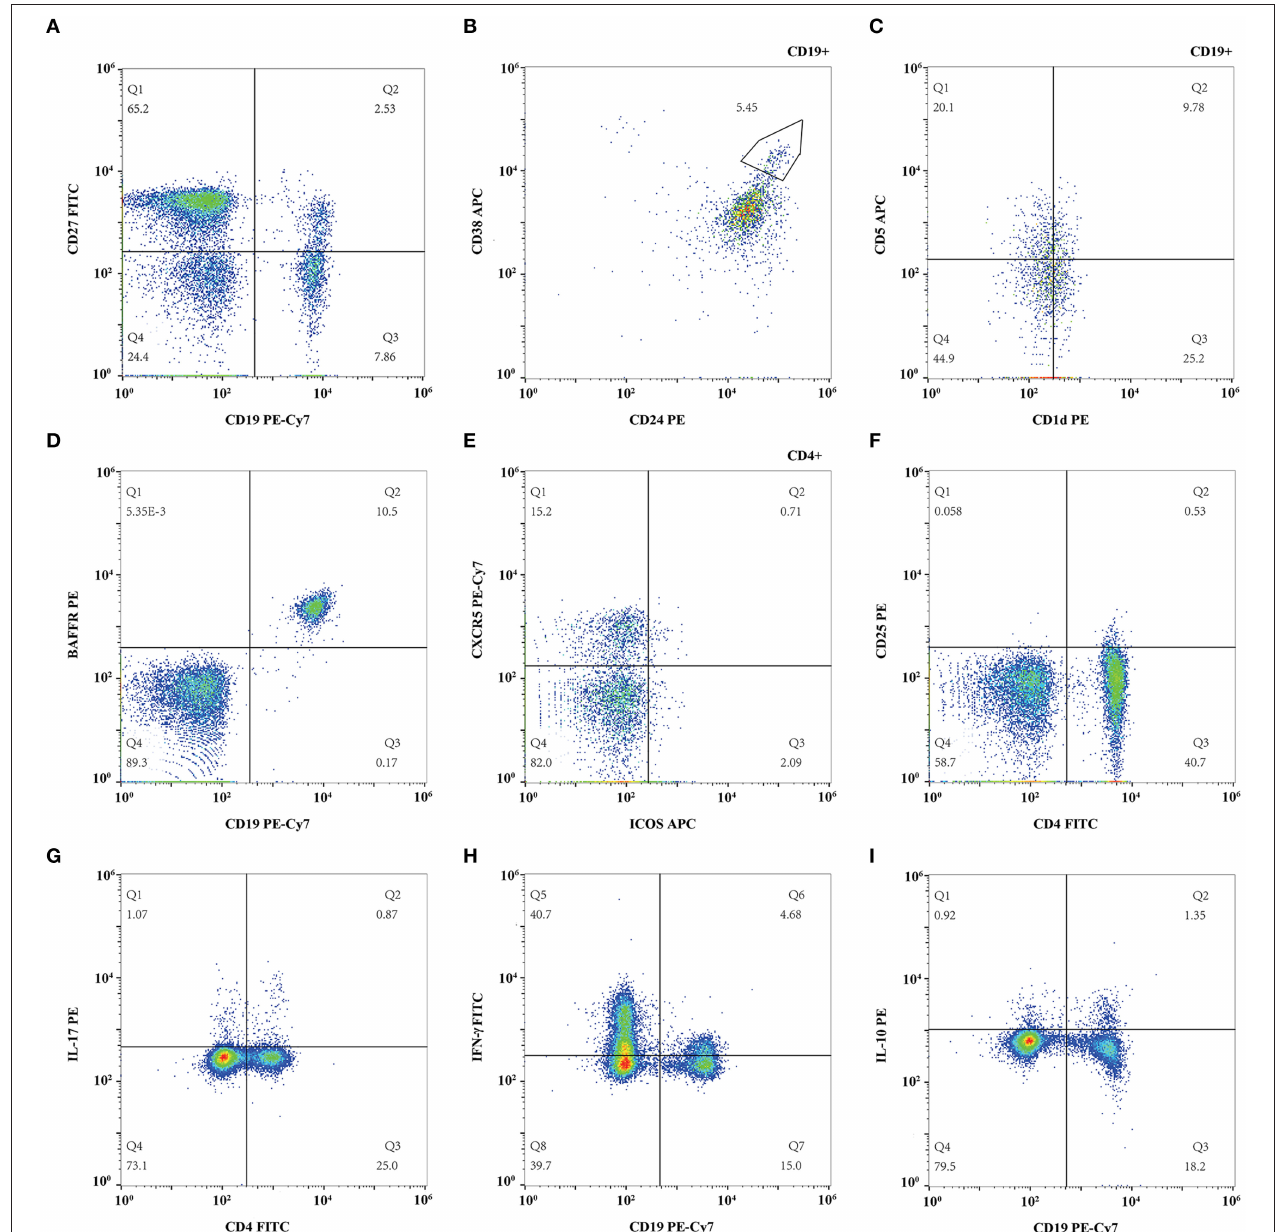
FIGURE 1 | Representative flow cytometry figure of lymphocyte subsets. (A) CD19 + CD27 + memory B cell and CD19 + CD27 − naïve B cell; (B) CD19 + CD24 hi CD38 hi regulatory B cell; (C) CD19 + CD5 + CD1d hi regulatory B cell; (D) CD19 + BAFFR + B cell; (E) CD4 + CXCR5 + ICOS + follicular helper T cell. (F) CD4 + CD25 hi regulatory T cell; (G) IL-17 expressing CD4 + T cell; (H) Interferon (IFN)- γ expressing CD19 + B cell; (I) IL-10 expressing CD19 + B cell.